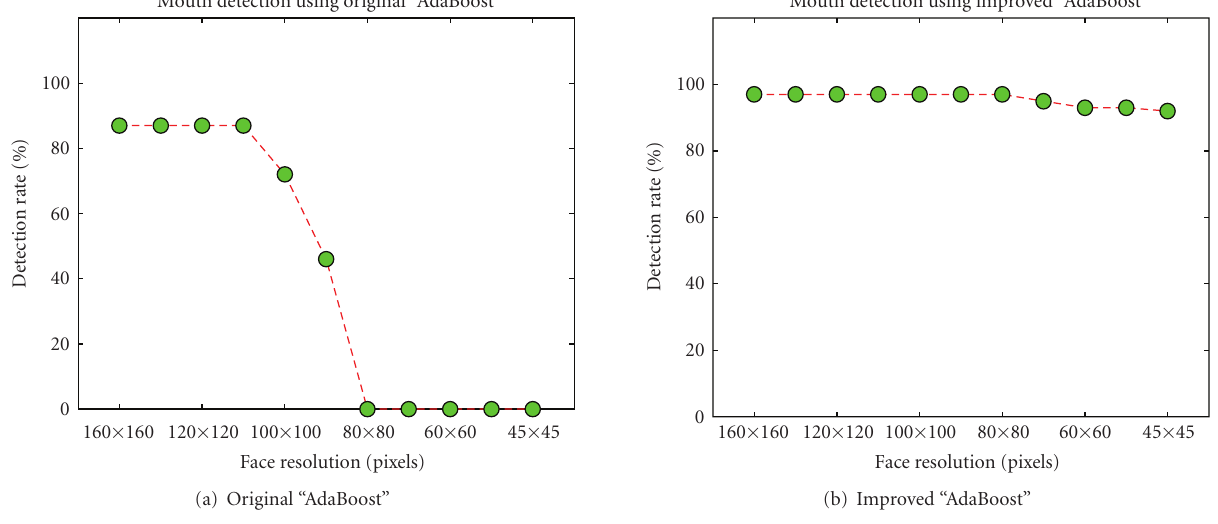
Figure 4: Mouth detection result. Both detectors are trained using same